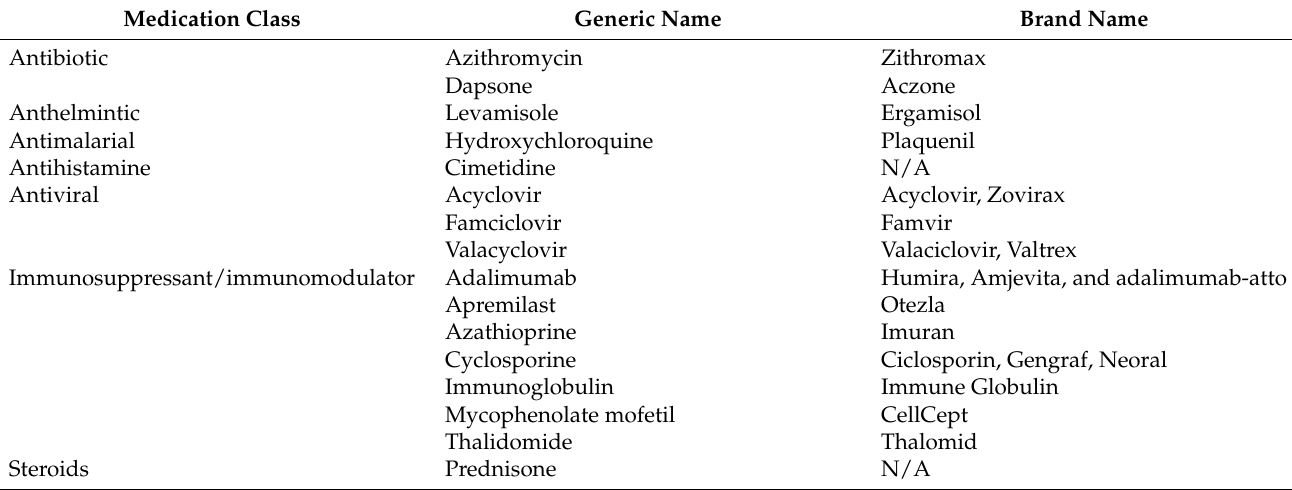
Table 3. This table is an overview of the current recommendations for each type of treatment indicated in the literature [1,20]. Both generic names and brand names, when applicable, are provided. Adapted from “Clinical Features, Diagnosis, and Treatment of Erythema Multiforme: A Review for the Practicing Dermatologist” by Sokumbi et al. [1] with permission from John Wiley and Sons Publishing on behalf of the International Journal of Dermatology, © 2021. Medication